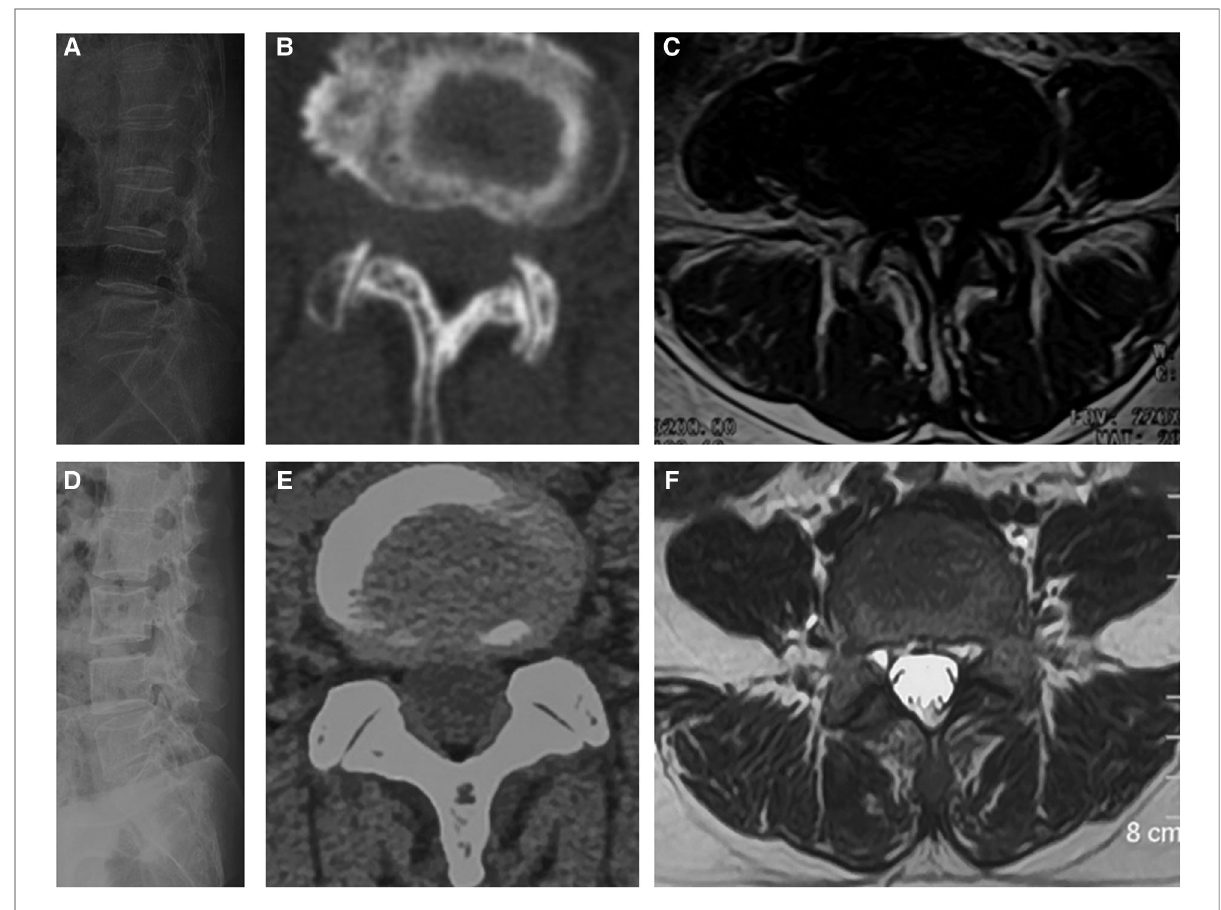
FIGURE 1 ( A, B and C ) are x-ray, CT and MRI of DLS patients, respectively. ( D, E and F ) are x-ray, CT and MRI of Normal subjects